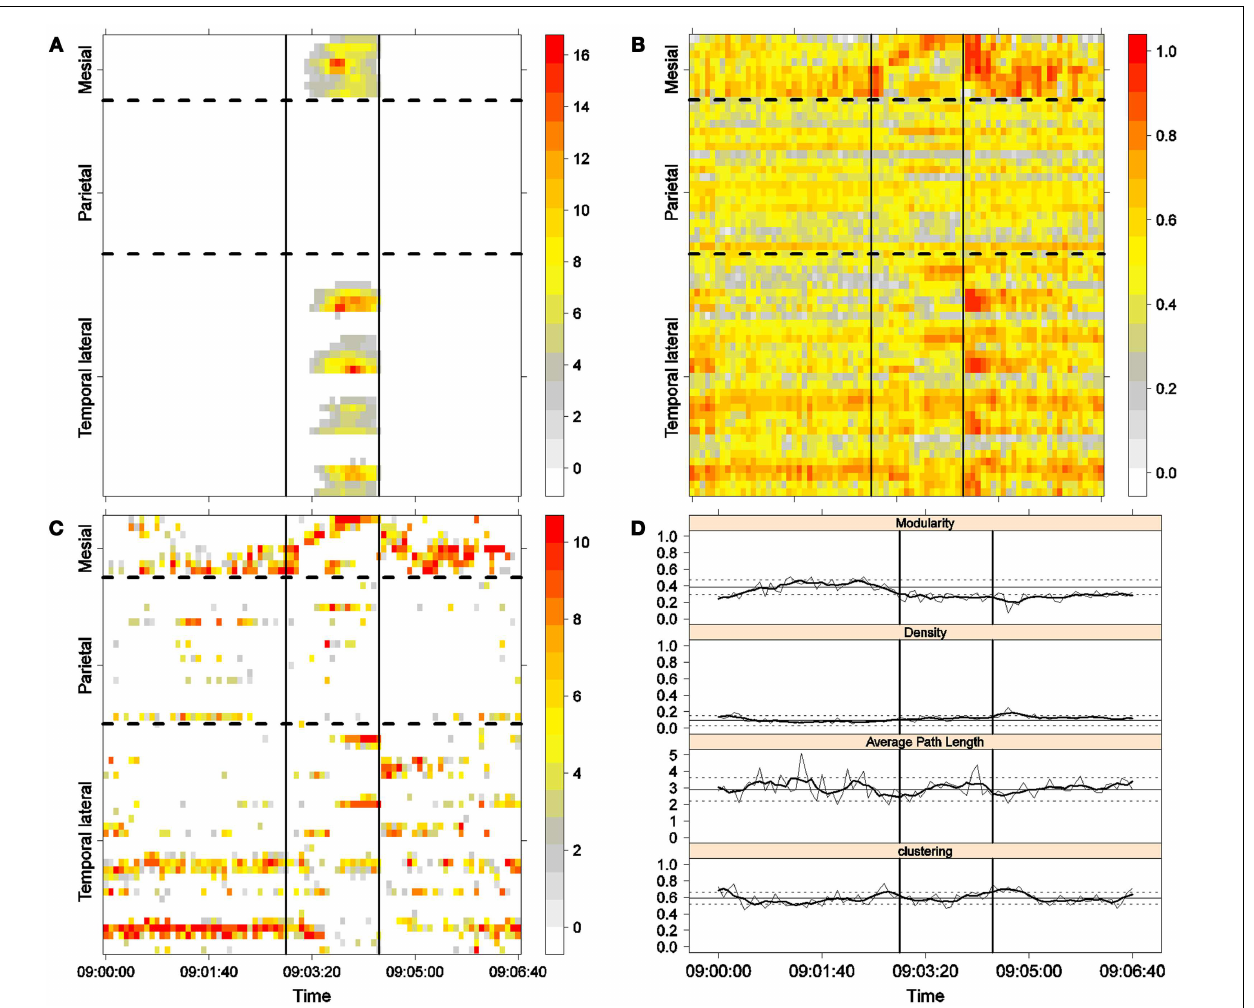
standard deviations of the corresponding measures during the interictal stage. The calculated values for each epoch are indicated by a thin, solid line, and the moving average of five consecutive epochs is shown with a thick, solid